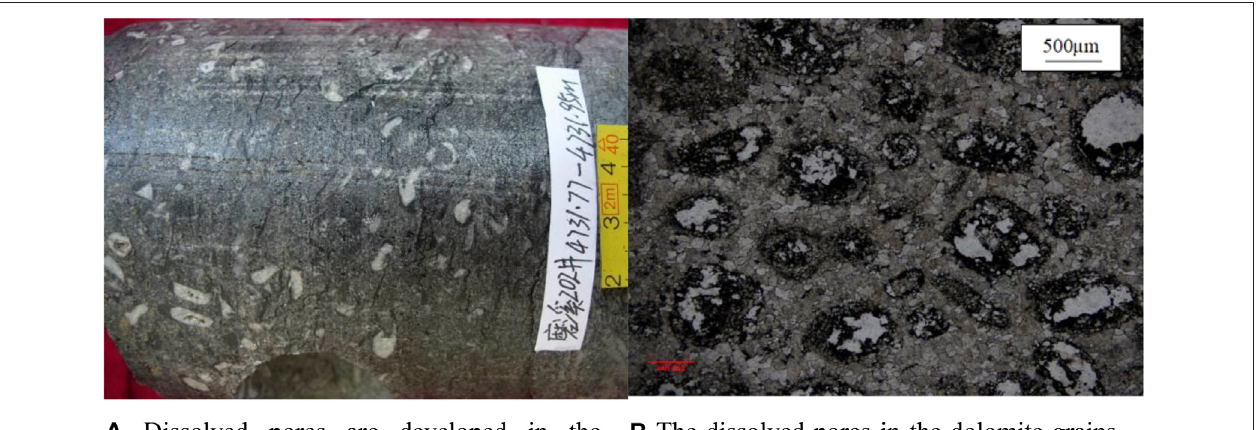
Frontiers in Earth Science |